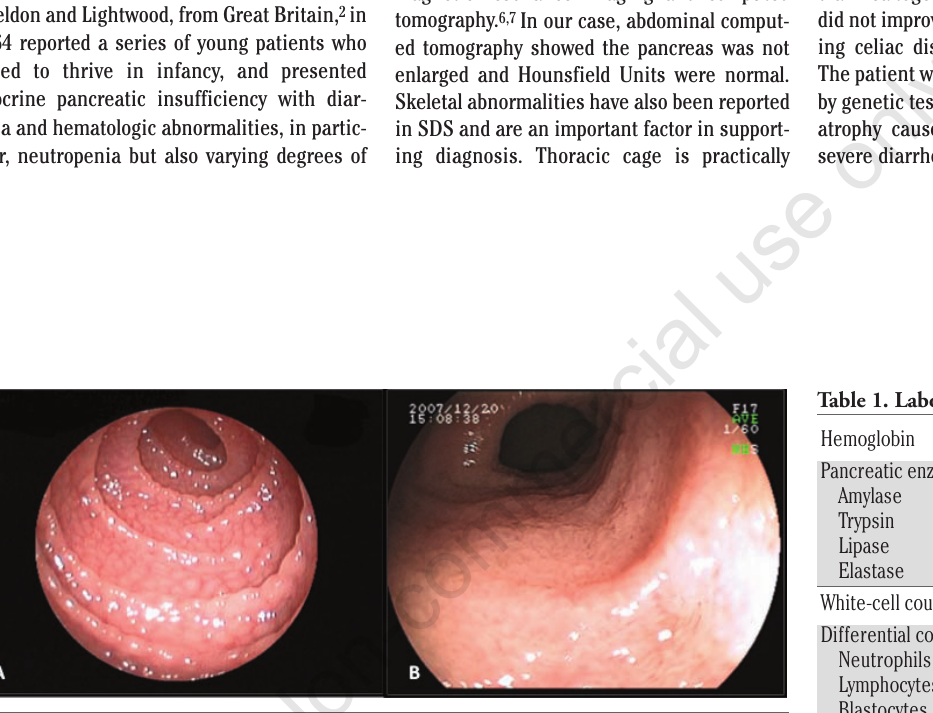
Figure 1. Endoscopic view: diffusely-scattered granular mucosa in (A) duodenum and (B) terminal ileum.